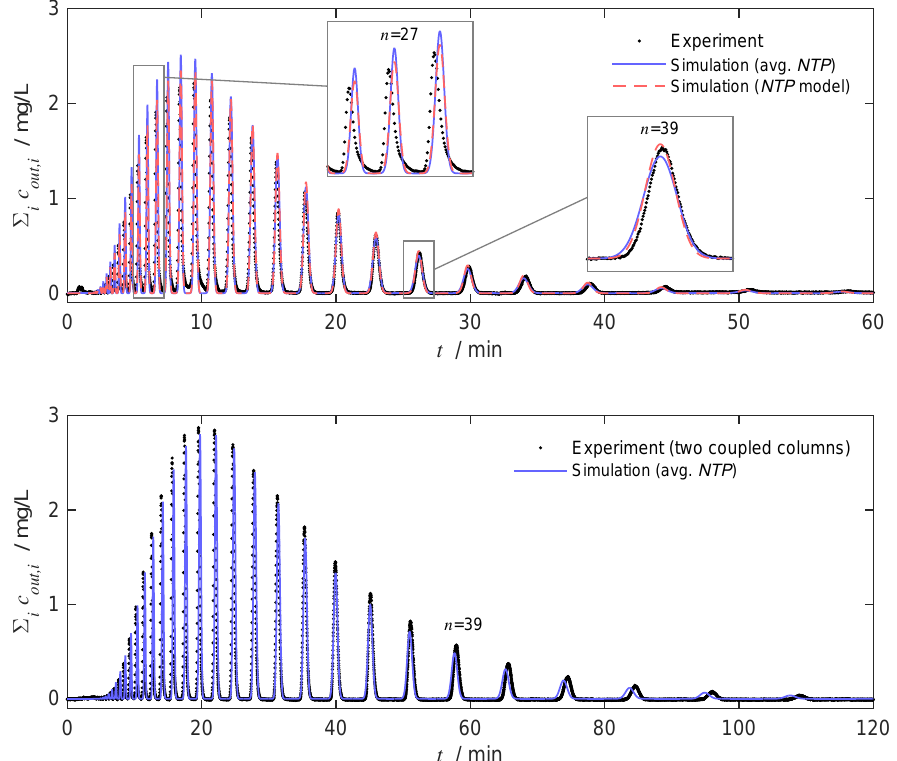
Figure 9. Validation of the modeling approach by discrete convolution. Symbols—experimental data, lines—simulated total outlet concentration, Σ i c out , i ( t ) , acc. to Equation (12). Top —Independent experiment not used for parameter determination (25vol % ACN, 43.8 ◦ C, 1mL/min, 10 µ L of PEG1400, 1g/L). Simulations with averaged ( NTP = 9700) and interpolated values for NTP , respec- tively. Bottom —Experiment with two coupled columns of the same size, simulated with averaged NTP = 10,000 for each column (25vol % ACN, 40 ◦ C, 0.7mL/min, 100 µ L of PEG1400,